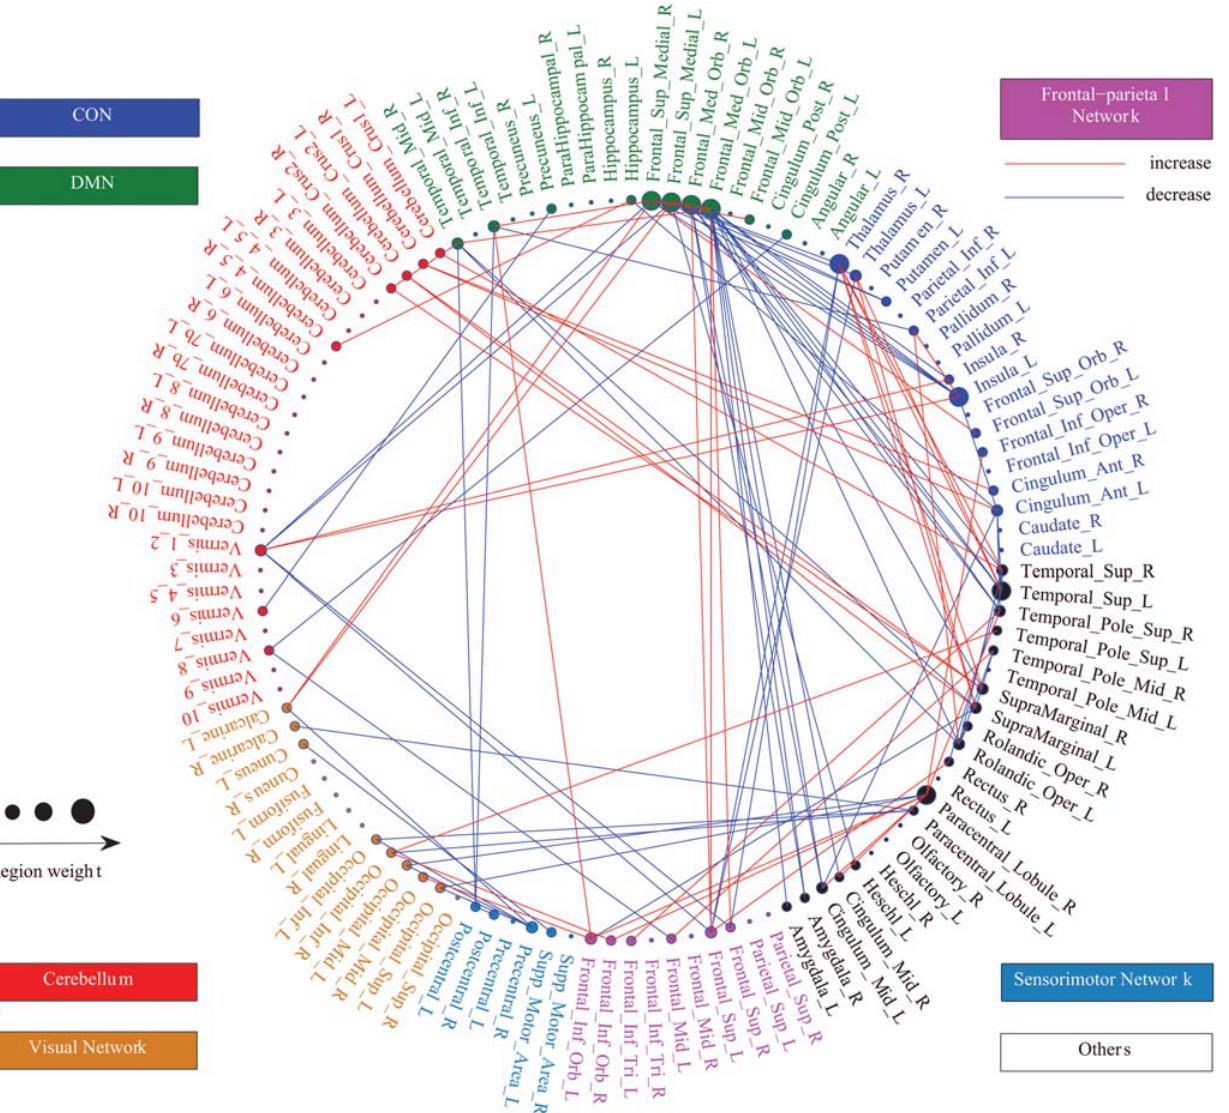
Fig 3. Region weights and the distribution of the 105 consensus functional connections. Regions are color-coded by category (CON, blue; DMN, green; cerebellum, red; visual network, brown; sensorimotor network, cyan; frontal-parietal network, rose; and others, black) and size-coded by weight. The line colors representing the change directions of the consensus functional connections in the patients are red for increases and blue for